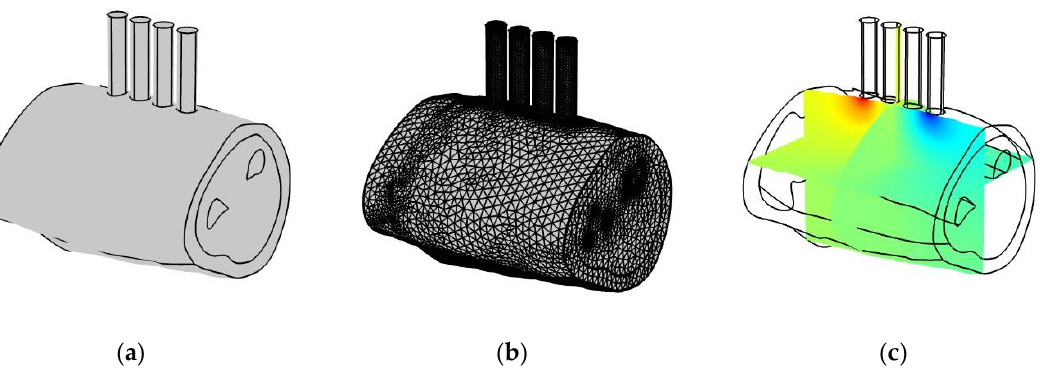
Figure 3. Potential distribution in the forearm anatomical model simulation by the finite element method: ( a ) geometric representation of the model; ( b ) discretization of the model into geometric primitives; ( c ) potential distribution.